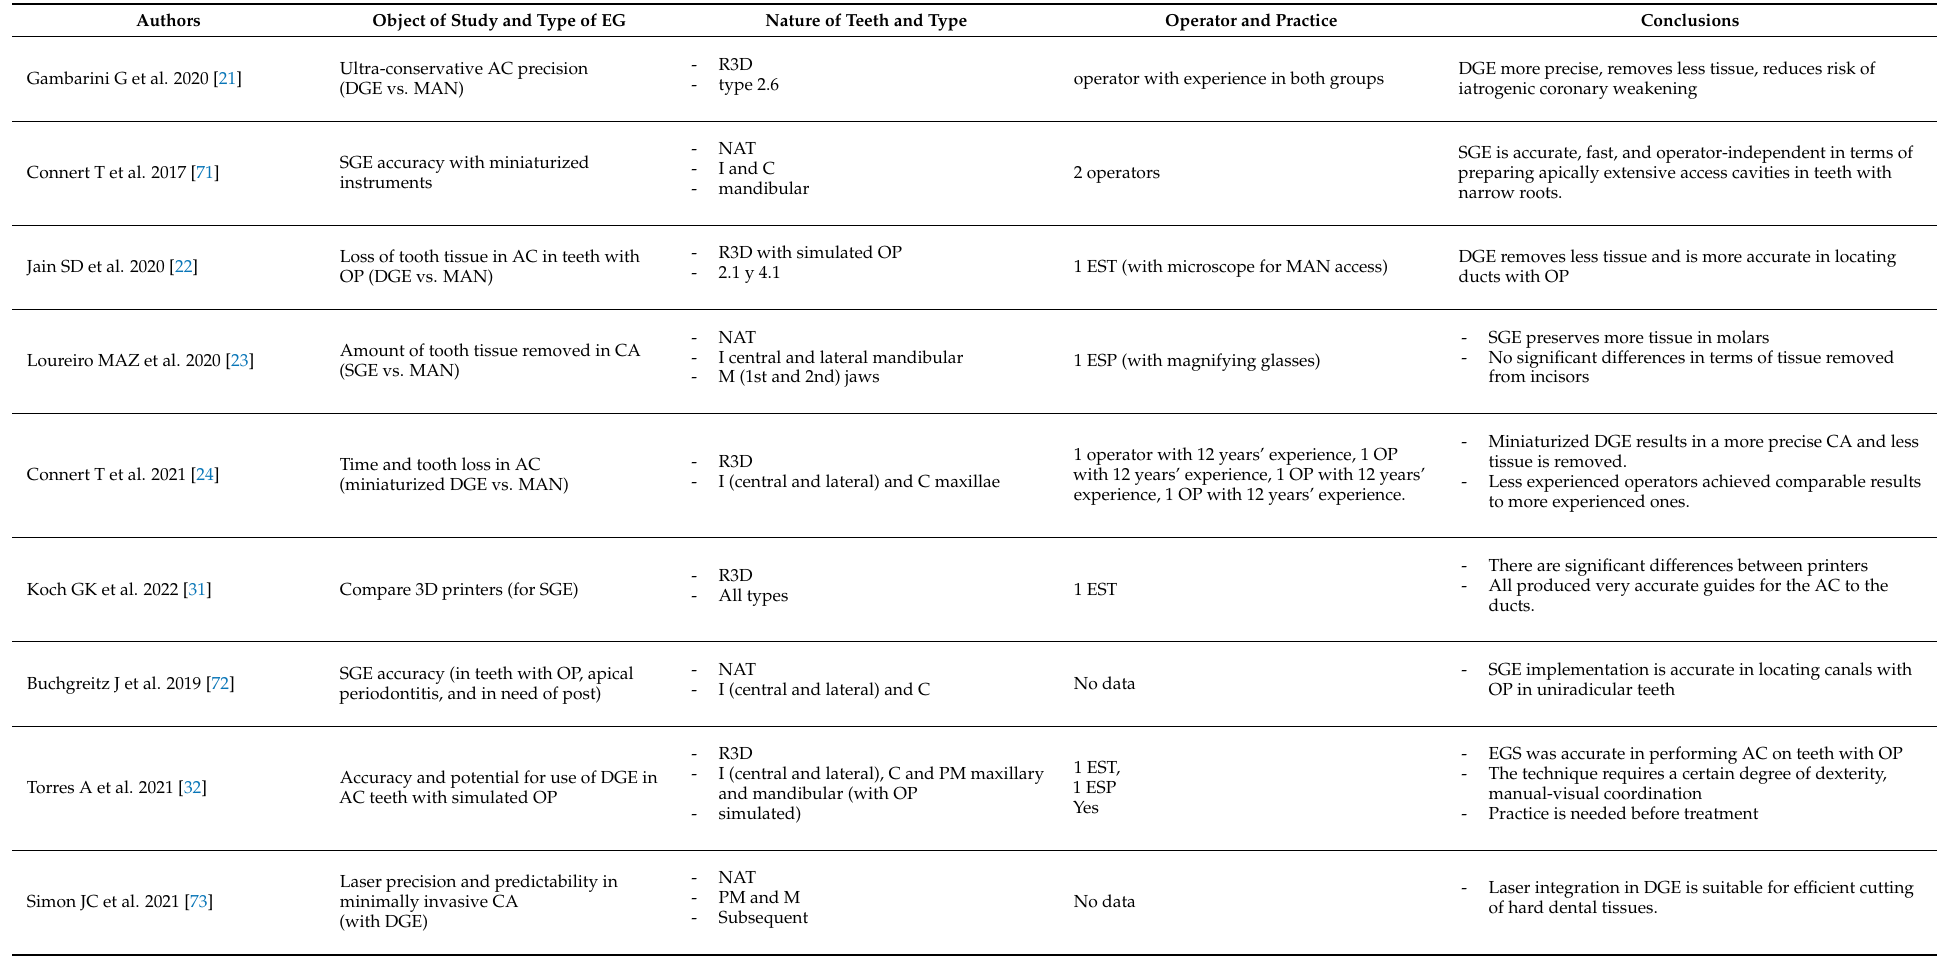
Table 1. Research articles included in review